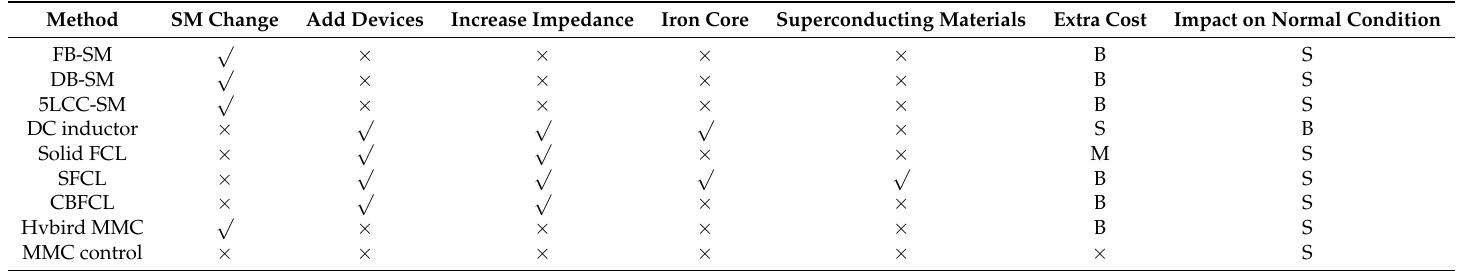
Table 4. Comparison of different short circuit current suppression